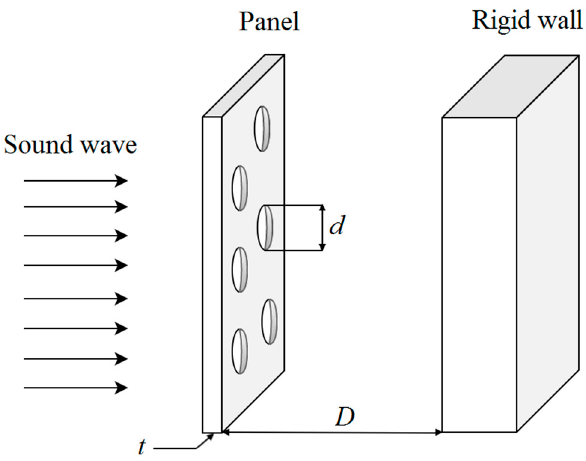
Figure 1. The schematic diagram of an MPP, which consists of a thin panel, an air gap, and a rigid